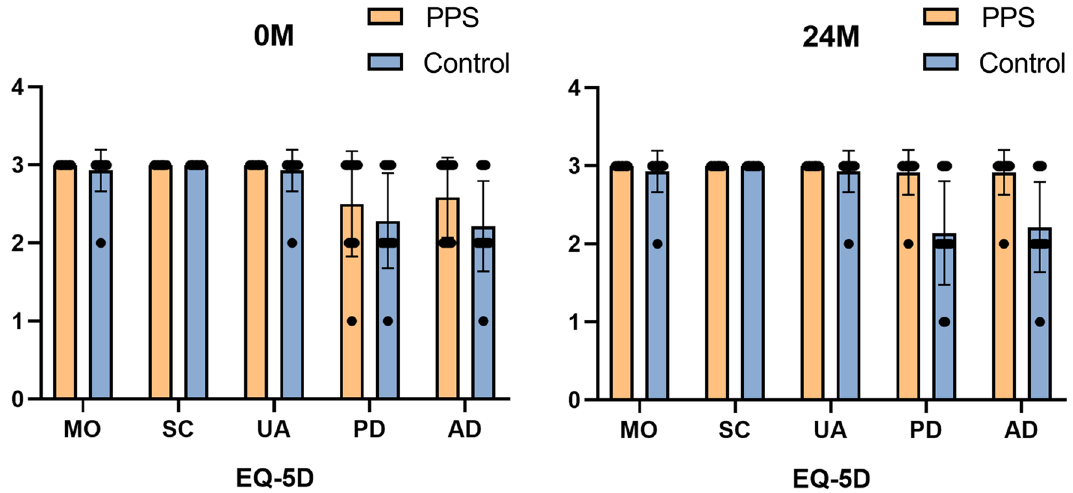
Figure 5. Scores in each domain of EQ-5D between PPS and control group at 0 M and 24 M. MO indicates mobility; SC, self-care; UA, usual activities; PD, pain/discomfort; and AD,